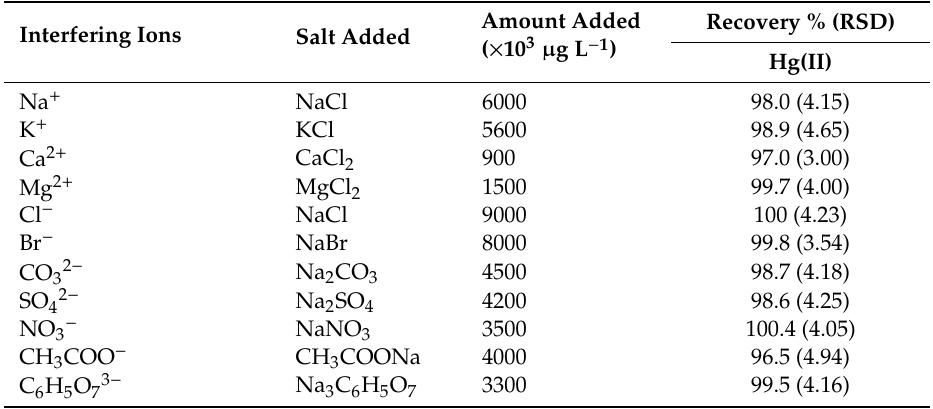
Table 2. Interference studies on the adsorption of analyte ions (experimental conditions: M n +